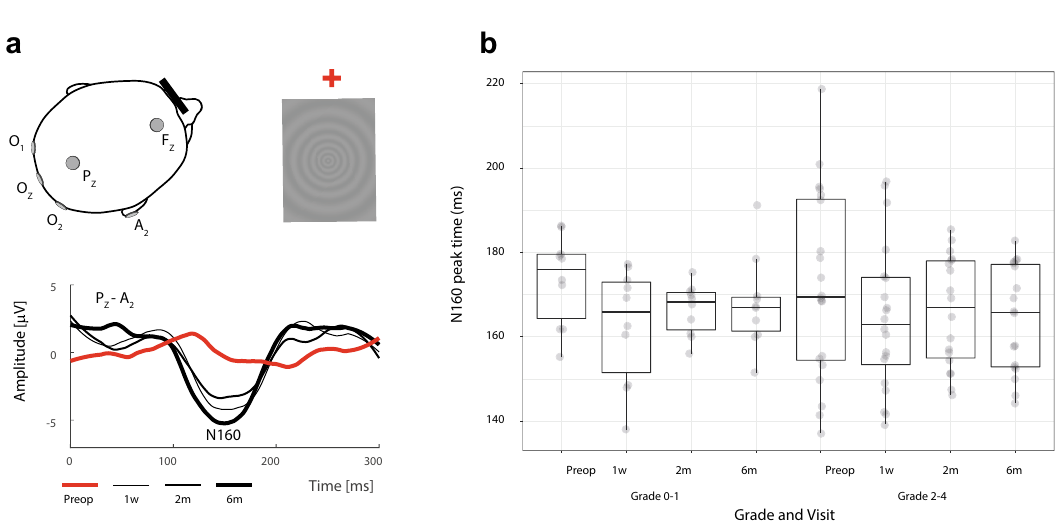
Figure 3. Schema illustrating the recording of pattern-reversal visual evoked potentials (P-VEPs) from the right eye fixating the red cross (left from the checkerboard) in patient #8. Such was the way the crossed fibers were examined. Active electrodes (O 1 , O z and O 2 ) and the reference electrode (F z ) were placed according to the 10–20 electroencephalographic system. The different waveforms represent preoperative (red line) and different postoperative (at 1 week, 3 months and 6 months) P-VEPs in O 2 –F Z derivation (the paradoxical lateralization taken into consideration) ( a ). Distribution of the P100 amplitude in P-VEPs between patients with the grade of compression 0–1 and 2–4. The grade was not a significant factor (p = 0.195). For the description of the boxplot parameters, see the legend of Fig. 1b ( b ).